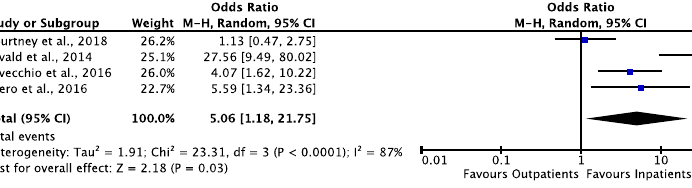
Figure 3. Forest plots of the